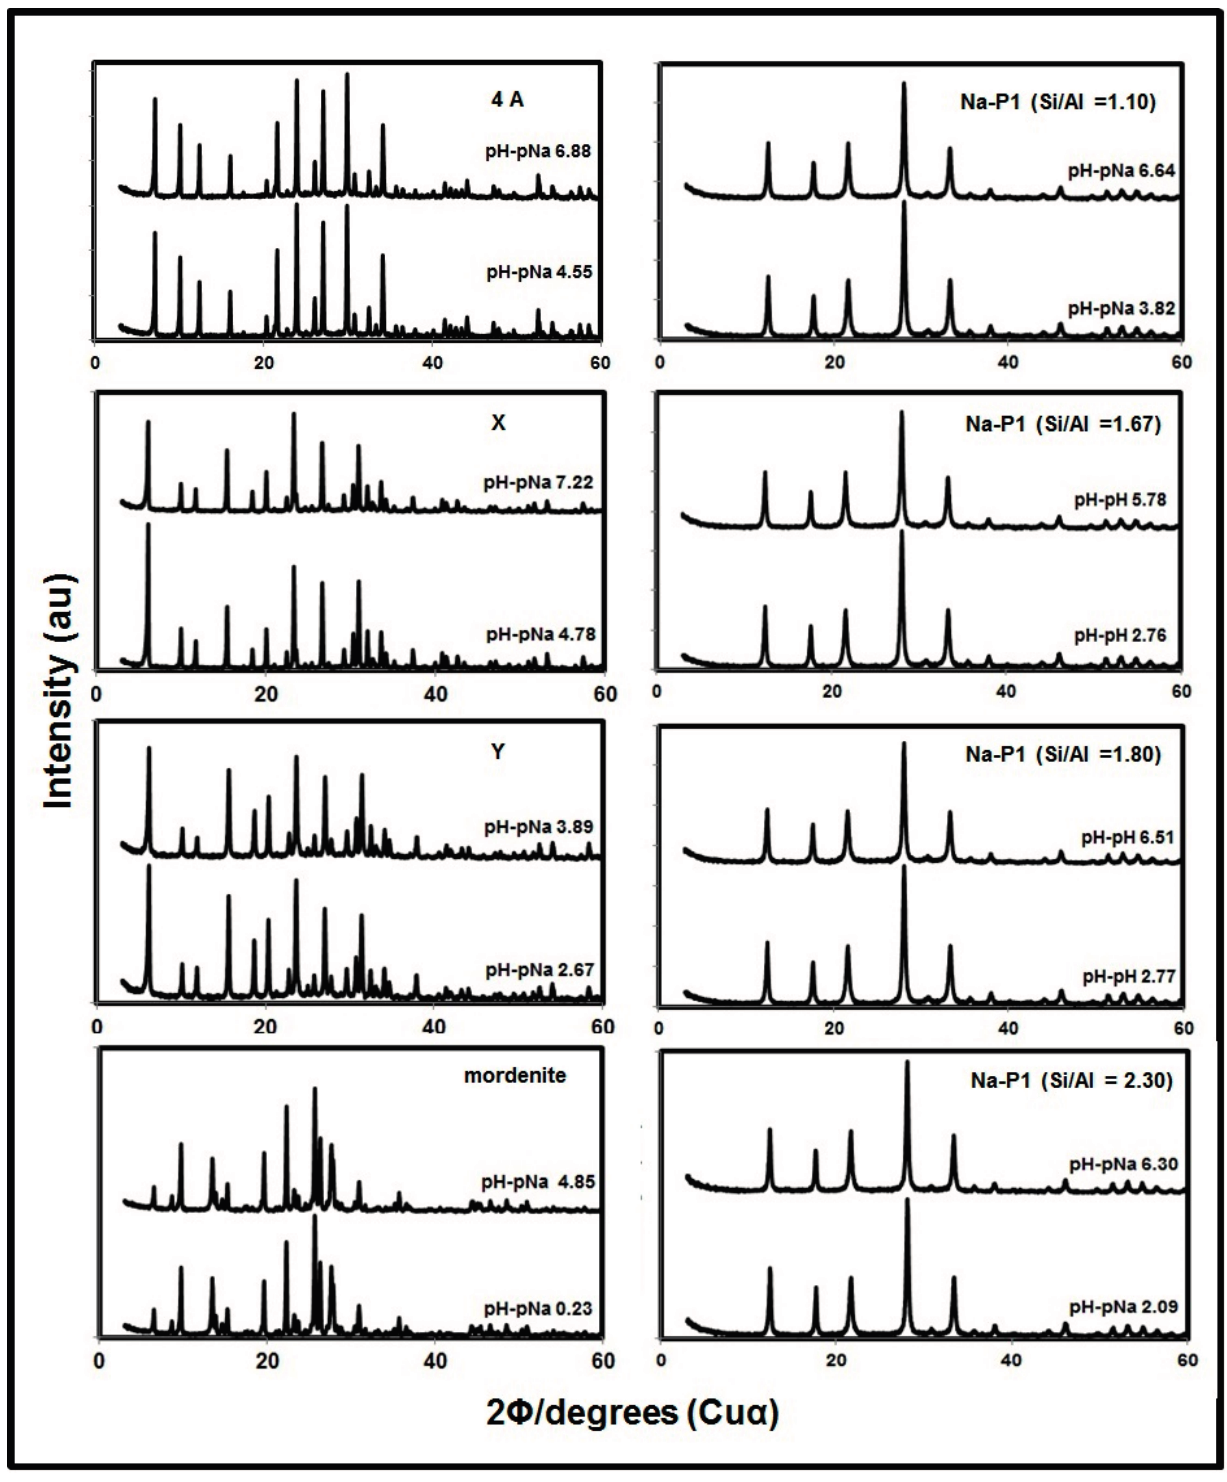
Figure 1. XRD patterns of zeolites after CEC measurement at different